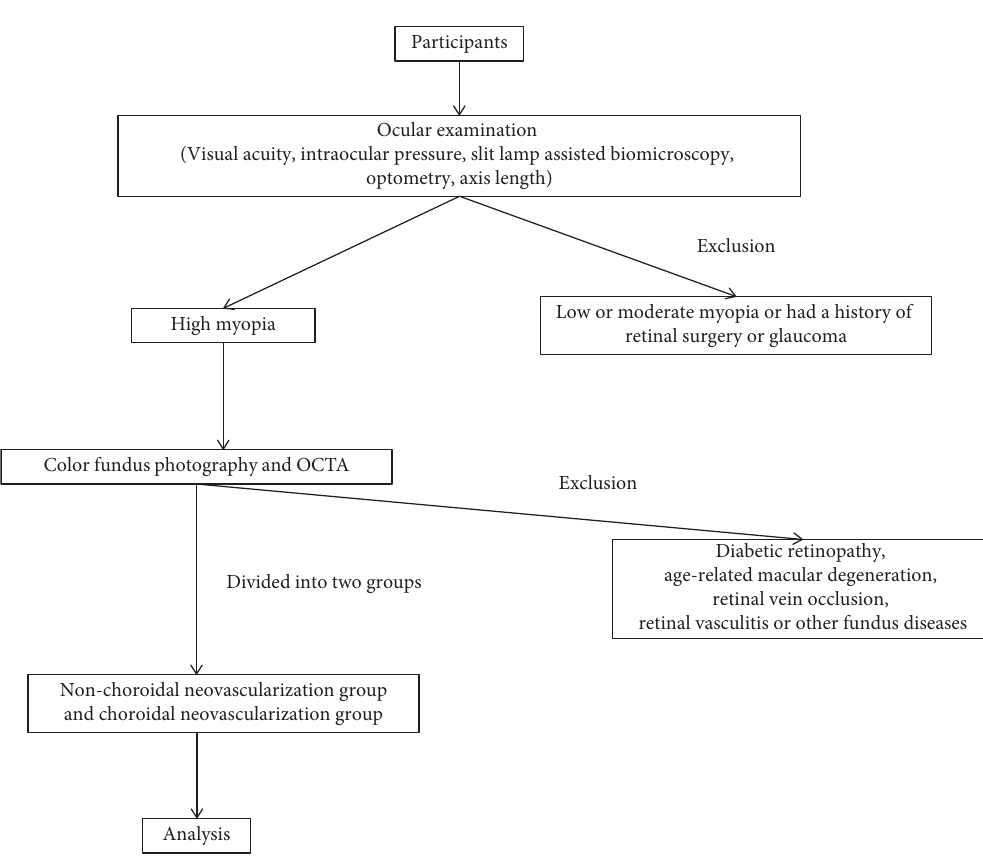
Figure 2: Te fow chart of the study